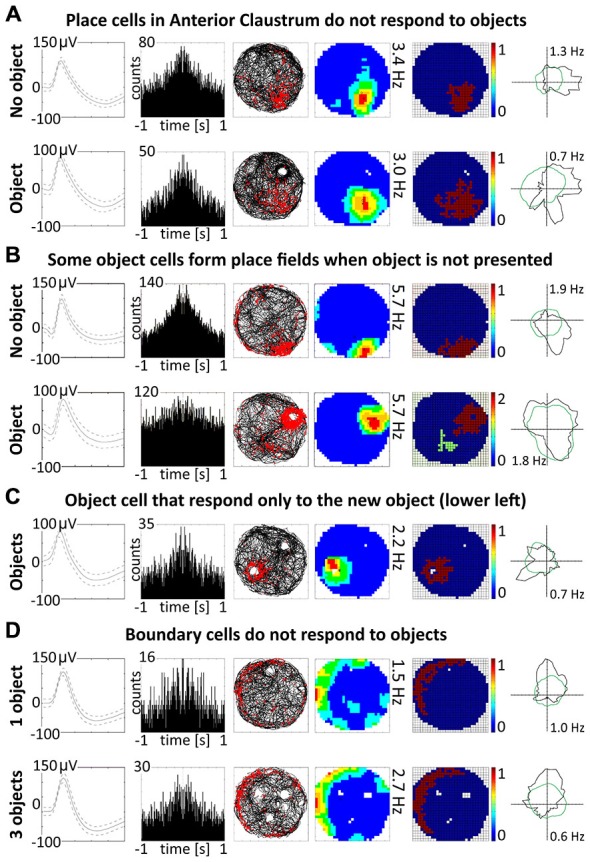
Other properties of claustral place and object cells. (A) Place cells do not respond to the objects. An example of a place cell recorded during two subsequent sessions with and without presentation of the object (glass bottle). (B) A small proportion of object cells (12.5%) form place fields when recorded without object. (C) Two cells were responsive only to the presentation of new object and did not react to known objects. (D) Boundary cells do not respond to the objects. For all examples are presented in rows: spike waveform; autocorrelation ± 1000 ms; path of the animal with superimposed firing activity; firing intensity map with a maximum firing frequency, place map and polar plot.